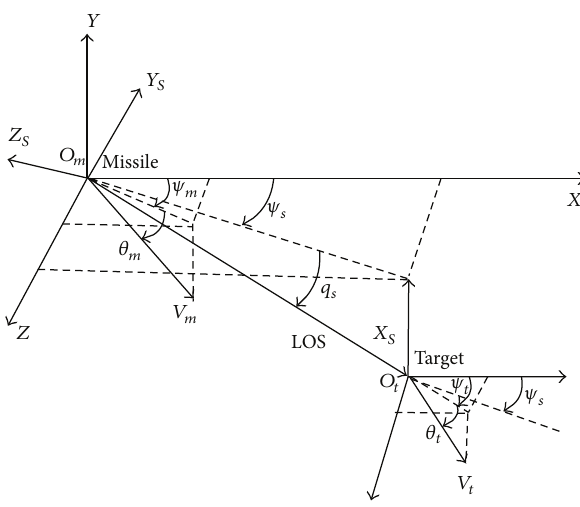
Figure 5: Three-dimensional pursuit